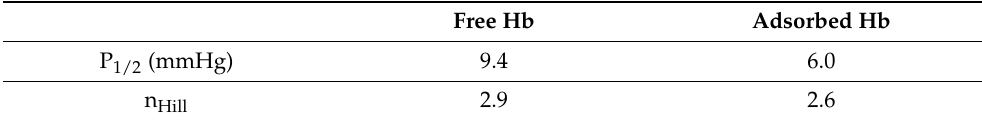
Table 2. Oxygen partial pressure at half saturation (P 1/2 ) and Hill coefficient (n Hill ) of hemoglobin (Hb) oxygen binding with and without nanoparticles in 0.1 mol.L − 1 phosphate pH 7.4 at 25 ◦